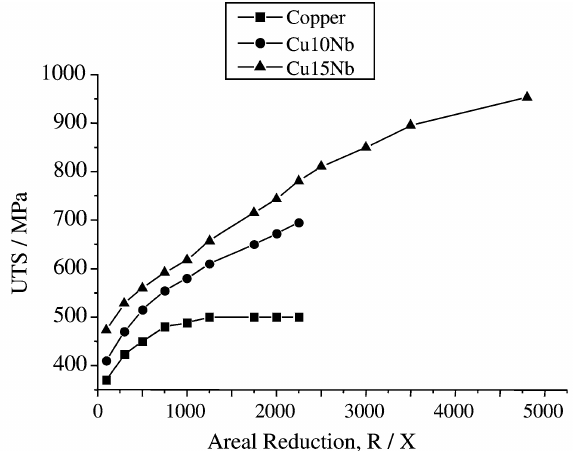
Figure 5. Nb filaments embedded into Cu matrix. R = 4.1x10 8 X. Magnification: 125 KX.